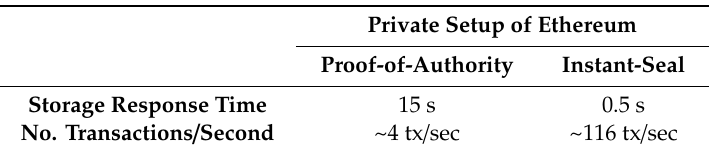
Table 5. Private blockchain setup